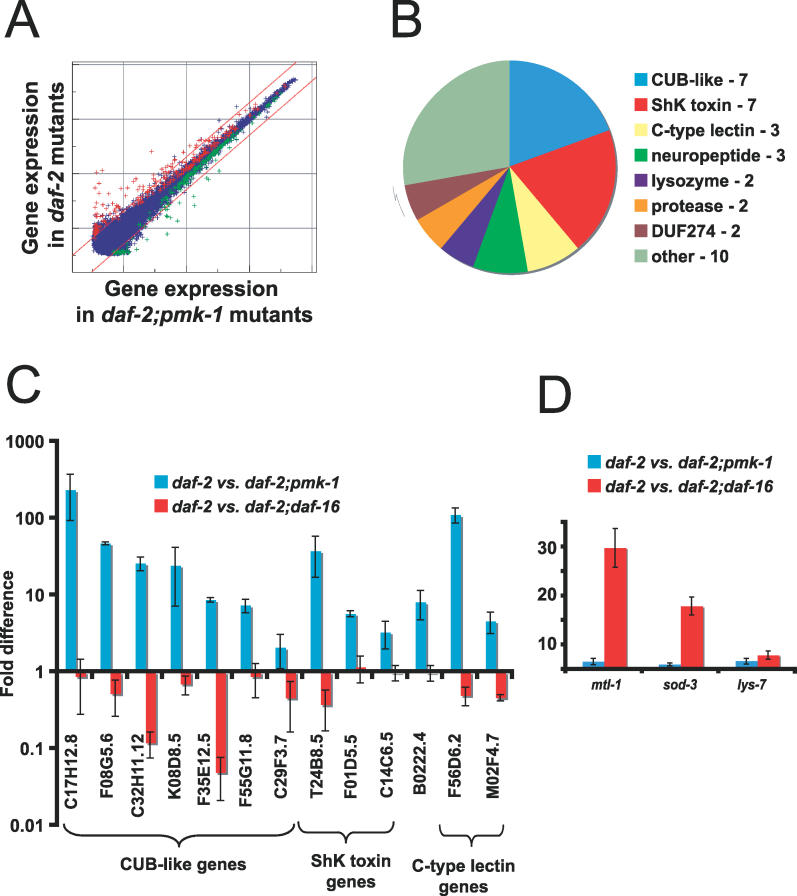
PMK-1 and DAF-16 Upregulate Distinct Genes(A) Intensity plot of genes upregulated by PMK-1 in daf-2(e1368) mutant. Plot represents signal intensity of all 22,500 sequences on Affymetrix C. elegans GeneChip. The x-axis shows expression level in daf-2(e1368);pmk-1(km25) animals and the y-axis shows expression level in daf-2(e1368) animals. Sequences colored red are considered upregulated by wild-type PMK-1 and sequences colored green are considered downregulated by wild-type PMK-1 (using Resolver; p <0.01). Diagonal lines delineate a 2-fold change. See Table S2 for a complete list of genes differentially expressed between daf-2 and daf-2;pmk-1.(B) Pie chart of gene classes upregulated by PMK-1. The top 36 genes induced are represented.(C and D) qRT-PCR comparing expression in daf-2(e1368) versus daf-2(e1368);pmk-1(km25), and daf-2(e1368) versus daf-2(e1368);daf-16(mgDf47). Results are the average of two biological replicates, each replicate measured in duplicate and normalized to a control gene. Error bars are SEM. (C) shows genes upregulated by PMK-1 and (D) shows genes upregulated by DAF-16.